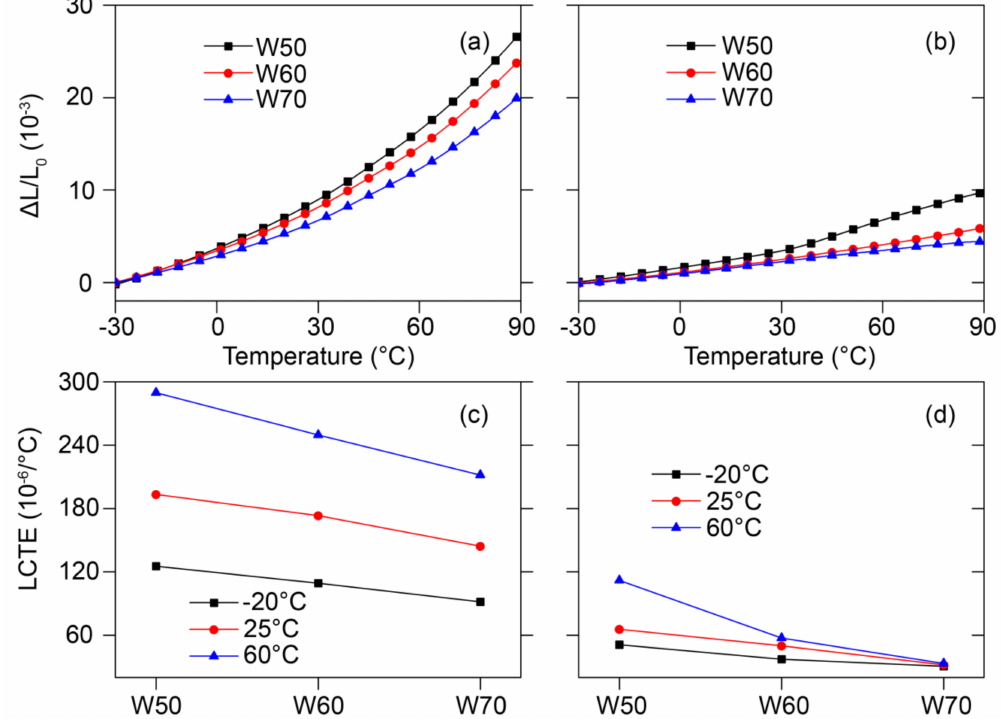
Figure 8. Thermal expansion strain as a function of temperature of Co-WPCs with high filler content: ( a ) in the thickness and ( b ) length directions, and LCTE in the thickness ( c ) and length directions ( d